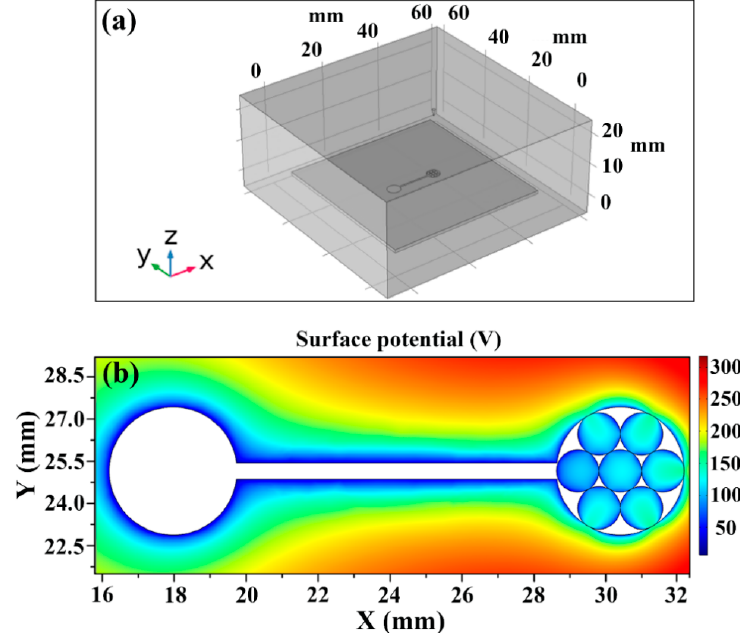
Figure 4. ( a ) Simulation model. ( b ) Electric potential simulation on the ITO film surface.